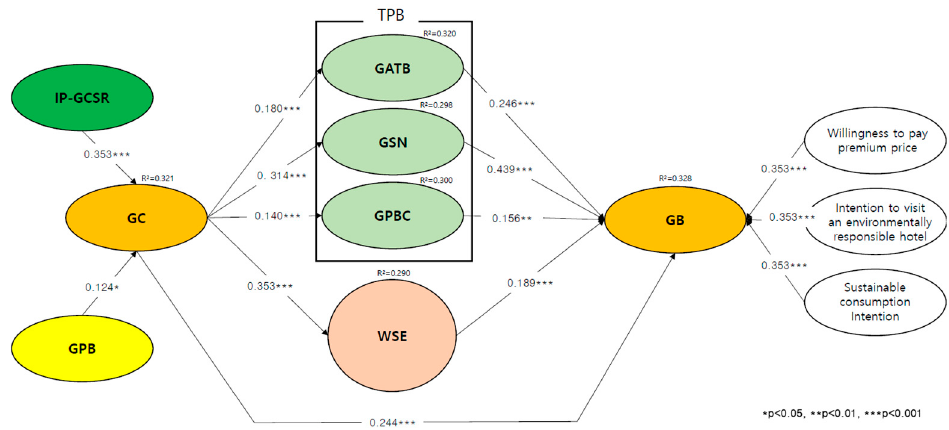
Figure 1. Structural equation model estimation and test for structural metric invariance. Note 1. Image Perception of Green Corporate Social Responsibility (IP-GCSR), Green Psychological Benefit (GPB), Green Consciousness (GC), Green related Theory of Planned Behavior (GTPB), Green related Attitude Toward Behavior (GATB), Green related Subjective Norm (GSN), Green related Perceived Behavioral Control (GPBC), Willingness to Sacrifice for the Environmental (WSE), Willingness to Pay Premium Price (WPPP), Intention to visit an environmentally responsible hotel (IVER), Sustain- able Consumption Intention (SCI). Note 2. Goodness-of-fit statistics for the measurement model χ 2 = 160.222, df = 87, p < 0.001, χ 2 /df = 0.543, RMSEA = 0.045, CFI = 0.993, IFI = 0.983, TLI =